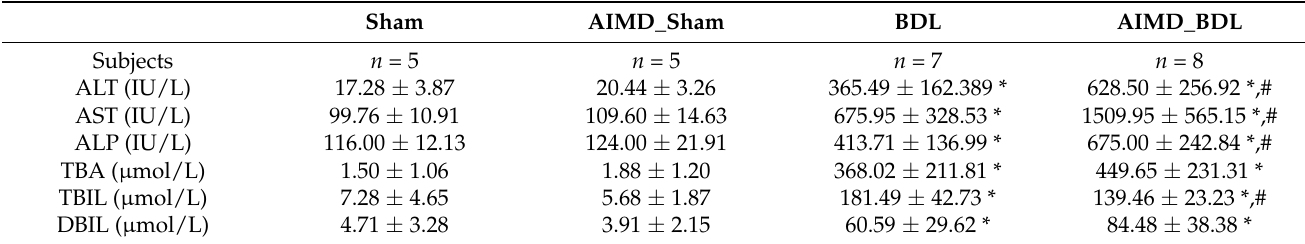
Table 1. Serum markers of liver injury in each group after AIMD and BDL surgery. Sham AIMD_Sham BDL AIMD_BDL n =